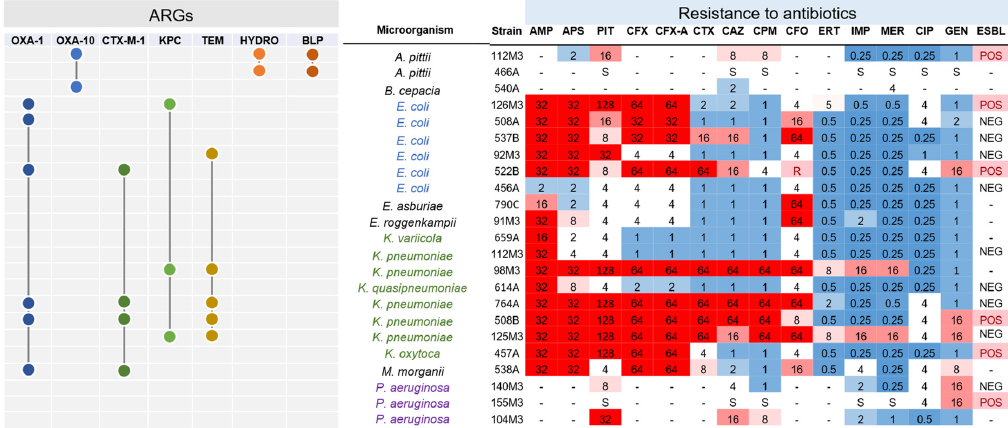
Figure 3. Shared beta-lactamases with 100% identity at the protein level. Seven beta-lactamase coding genes were found as shared among gram-negative strains analyzed. Connected circles indicate that the genes are presented in those strains. On the right, the antibiotic resistance profile of the analyzed strains is shown. Genes for bla OXA-1 and bla KPC are highlighted (red triangles) since these genes were identified in the functional screening carried out in this study. On the right, antibiotic resistance levels are indicated, with numbers indicating the resistance levels in mg/mL. Red indicates resistance to the antibiotic, while blue denotes sensitivity. In the final column it is indicated if the strain is extended-spectrum ß-lactamase (ESBL)-positive or -negative. AMP: ampicillin; APS: ampicillin/sulbactam; PIT: piperacillin/tazobactam; CFX: cefuroxime, CFX-A: cefuroxime axetil; CTX: cefotaxime; CAZ: ceftazidime; CPM: cefepime; CFO: cefoxitin; ERT: ertapenem; IMP: